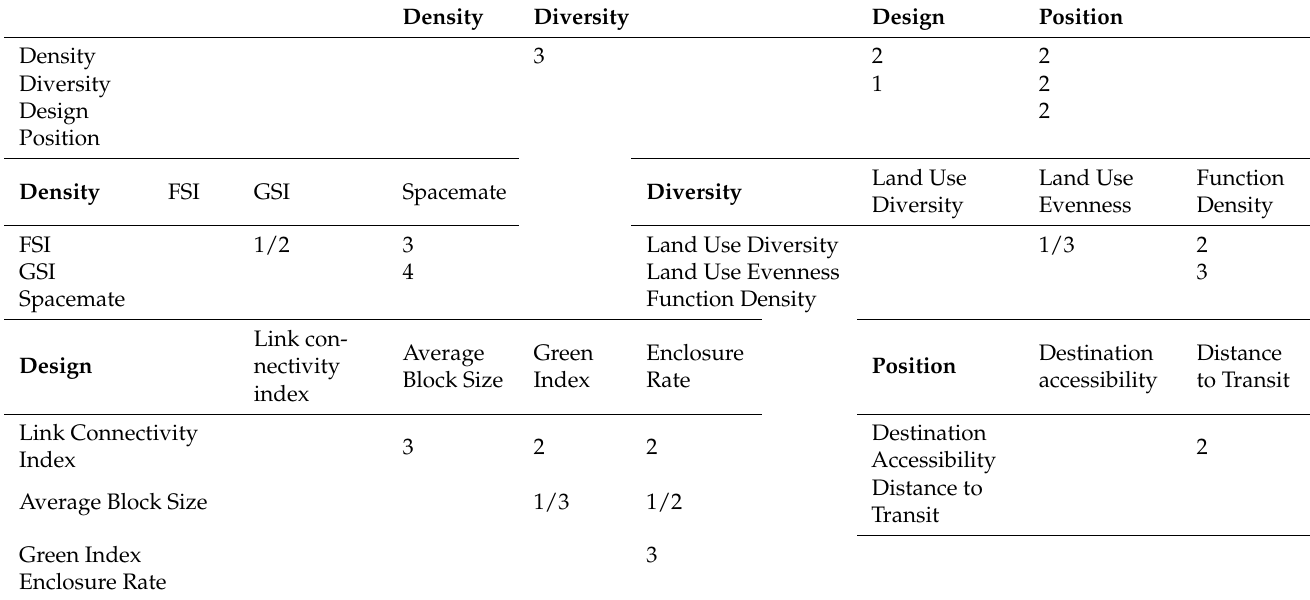
Table A5. Expert